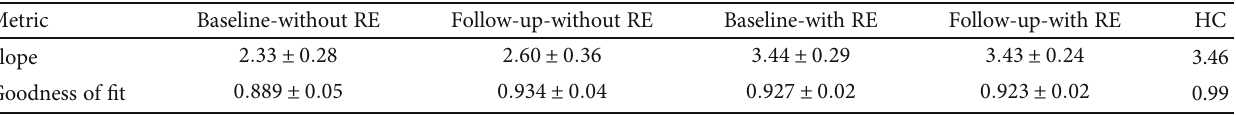
Figure 3: Mean ± standard deviation of the initial loading phase of the right and left leg of subjects with ABI while walking with and without the RE at baseline and at follow-up and a reference HC. The dotted lines are the best fi t lines for the loading pro fi le. Table 3: Mean ± standard error of initial double support (IDS) loading characteristics on the a ff ected side of all participants with ABI and IDS loading characteristics on the left side of one